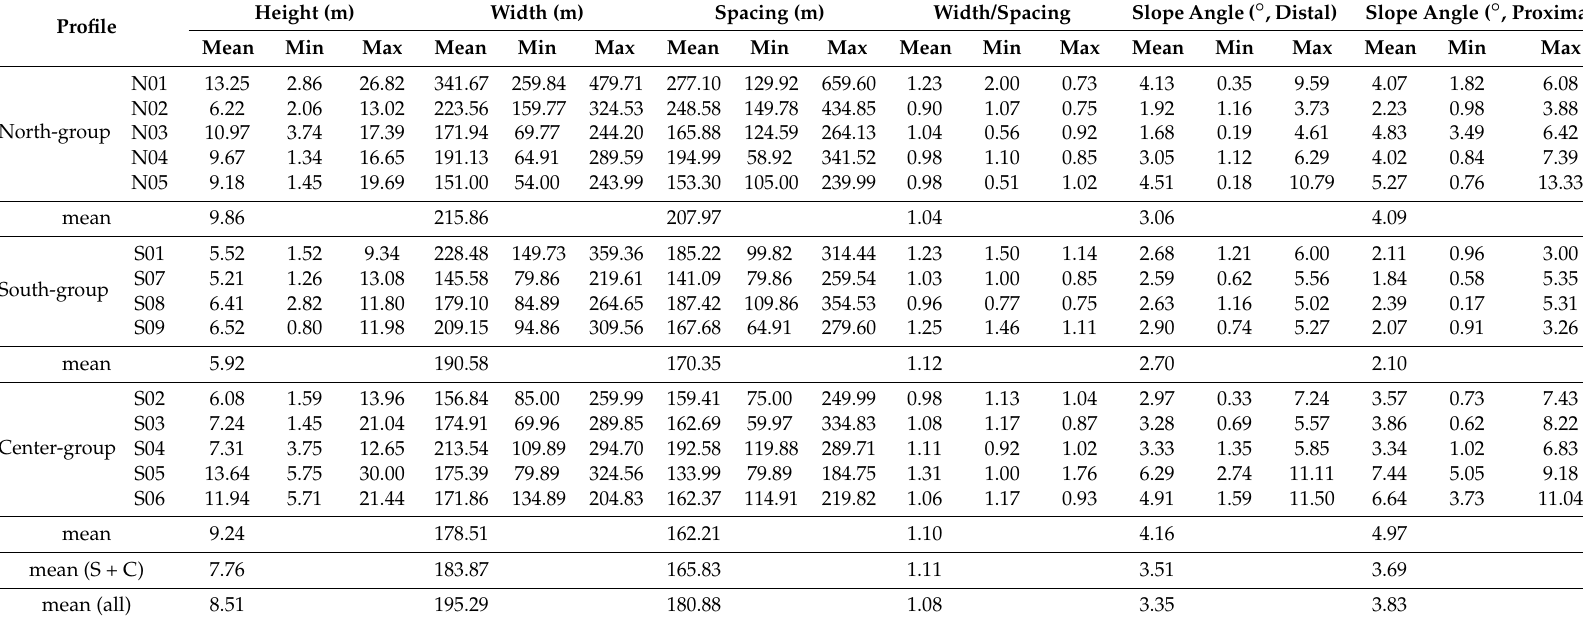
Table 1. Summary of all morphometric parameters of each elevation profile in the northern and southern sub-complex. For each profile, mean, the minimum and maximum values are shown. For each group, the mean its profile means is shown. Finally, the mean of the entire southern sub-complex (S + C) and the mean of all profiles is